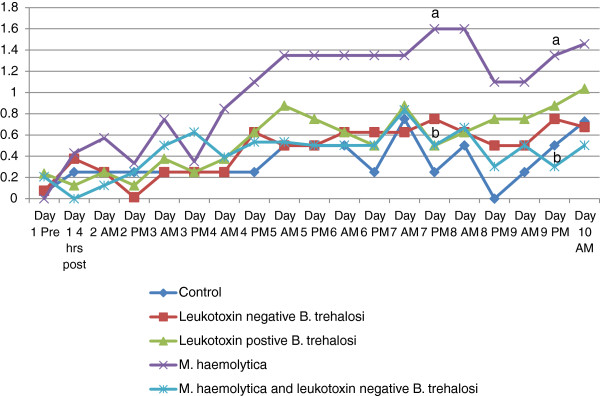
Respiratory score over time by treatment group. Line graph of respiratory score by treatment group for each time point when respiratory score was recorded. Time points that were statistically different are indicated by different letters (a or b).